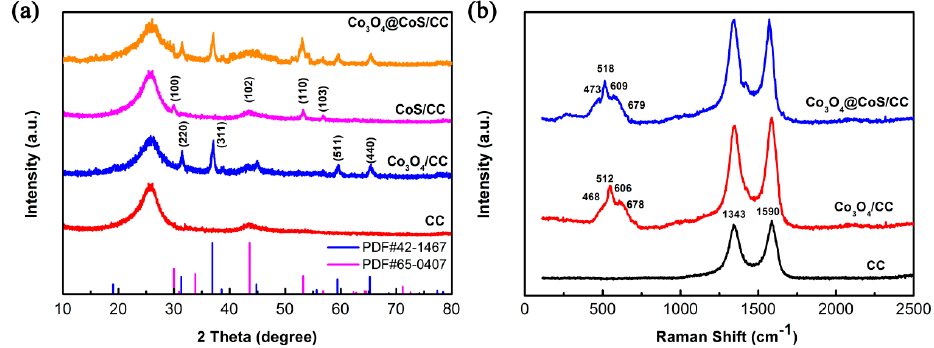
Figure 3. ( a ) XRD patterns; and ( b ) Raman spectra of CC and CC based composites.